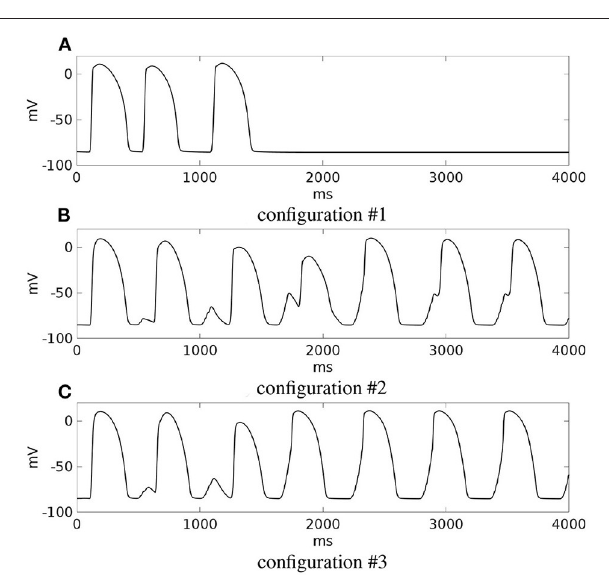
FIGURE 13 | Modifications of patient #2. (A–C) Transmembrane potential waveforms in the three modified configurations, computed from an epicardial size located in the BZ, at the exit of the transmural isthmus. M1 stimulation.